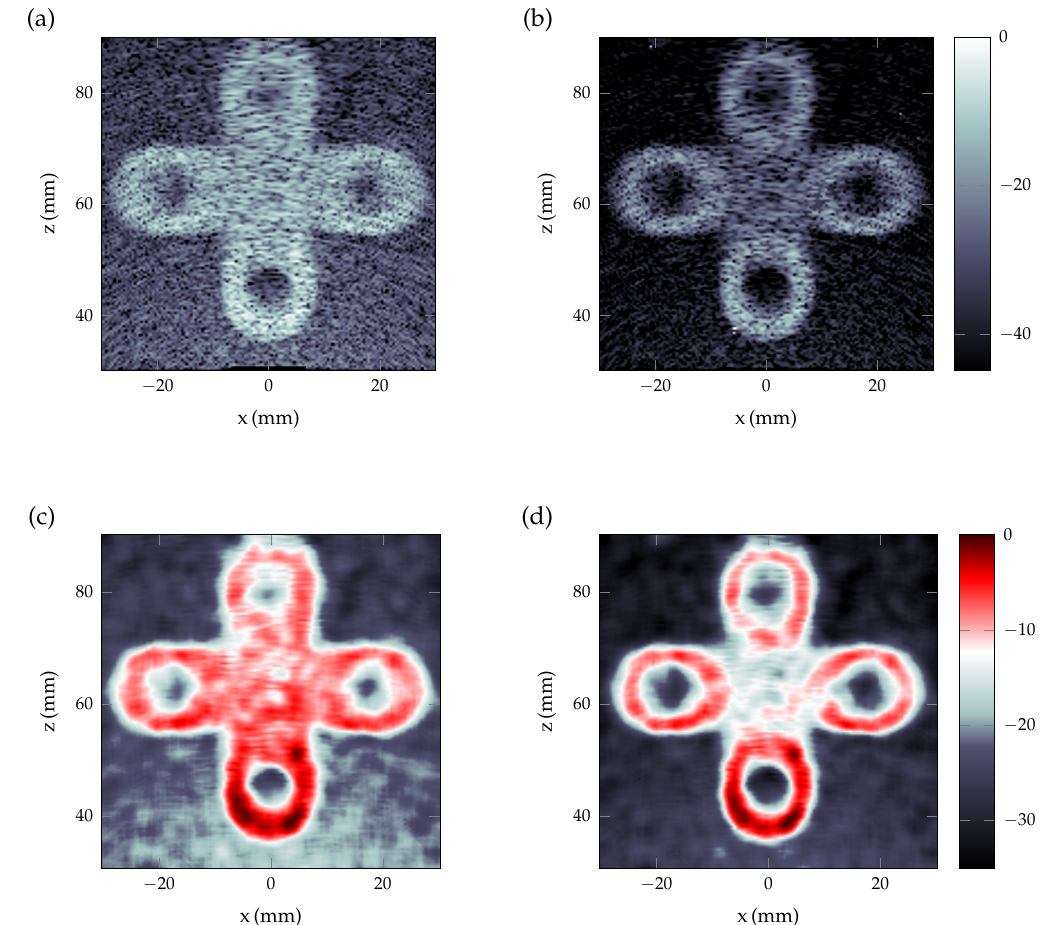
Figure 6. Simulated phantom analysis. Formed by interlaced tori section: ( a )DAS, ( b )RiB 10%, ( c )NLmeans-DAS and ( d